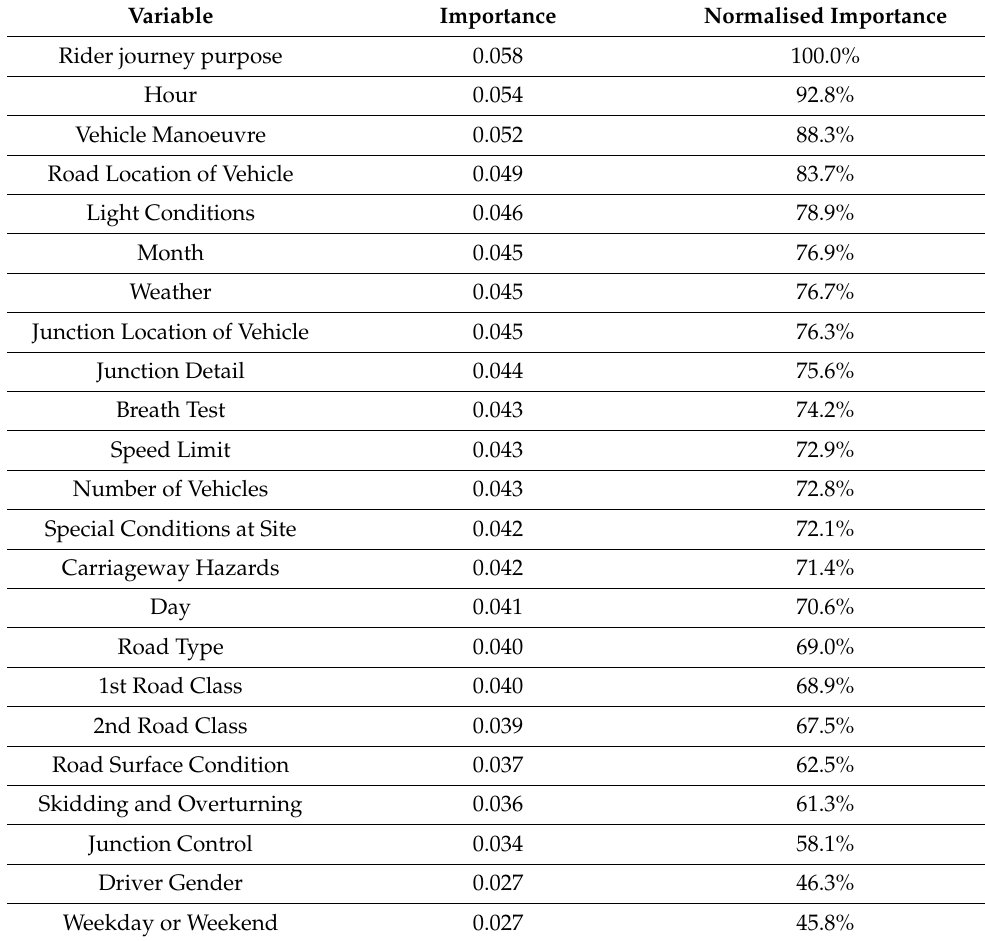
Table 6. Normalized importance of the input